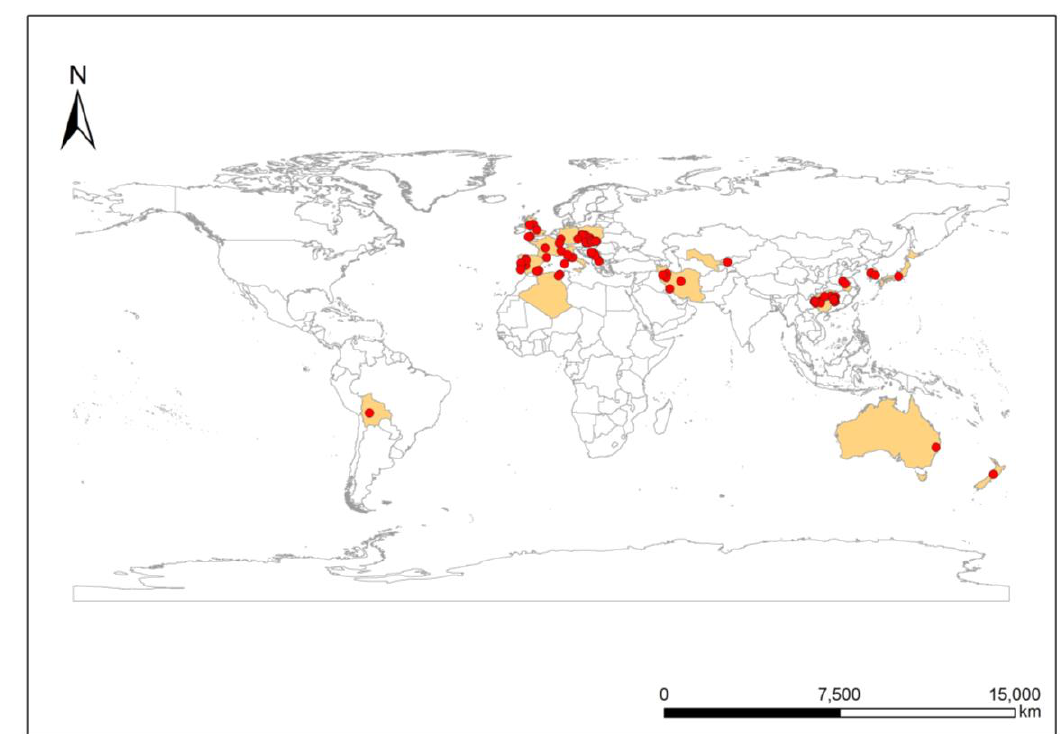
Figure 1. Geographical location of Sb studies related to mining/smelting activities retrieved from the scientific literature.